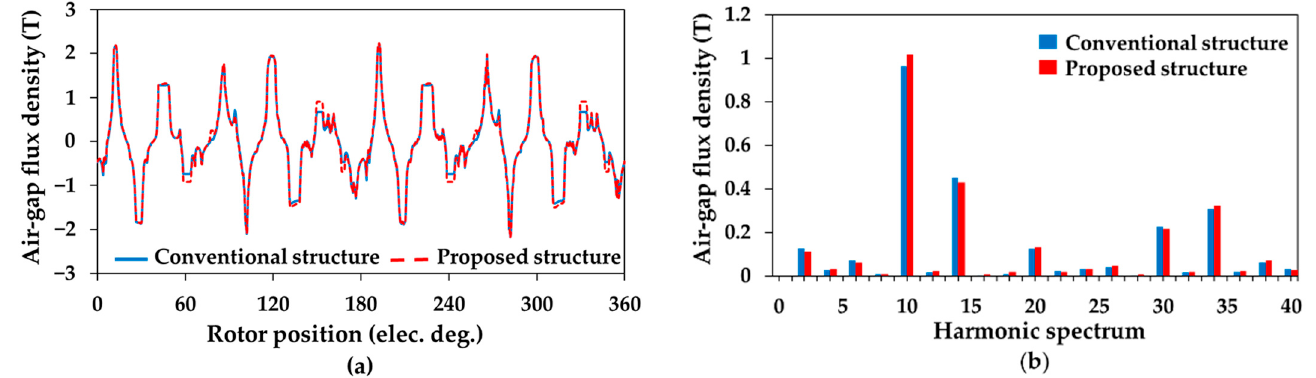
Figure 9. Air-gap flux density. ( a ) Waveforms. ( b ) Harmonic spectrum.